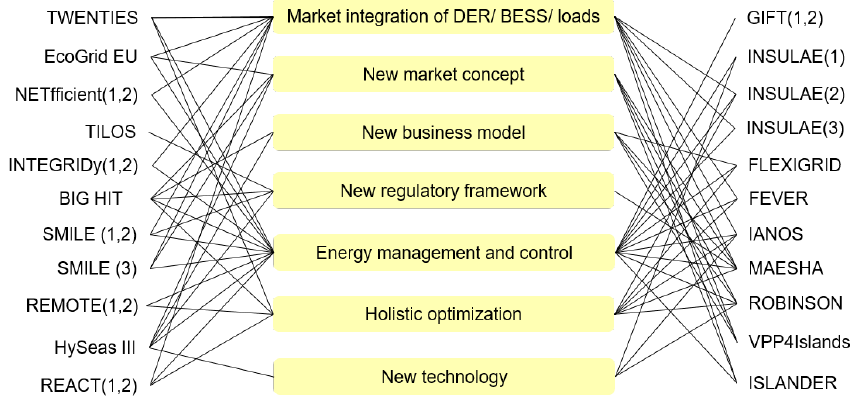
Figure 5. Focus areas and contributions of different multi-energy